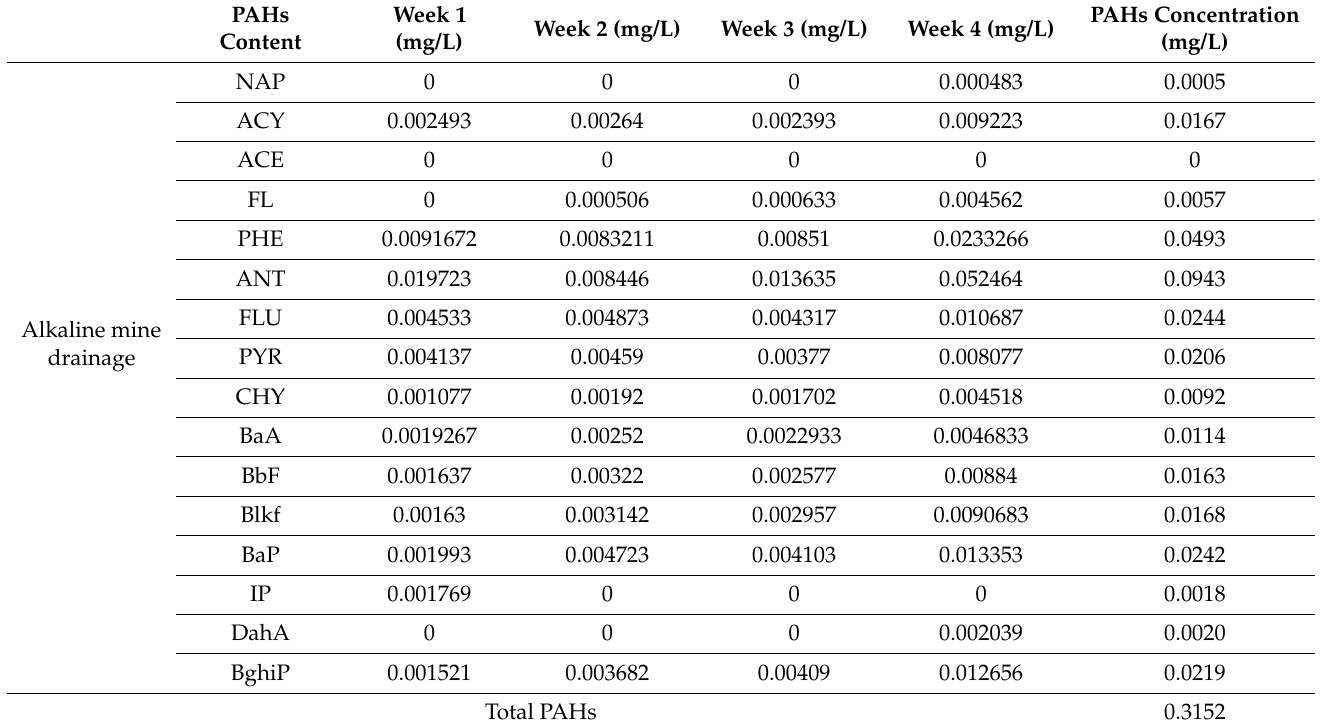
Table 6. The recovery of PAHs in an alkaline mine drainage @ 25 ◦